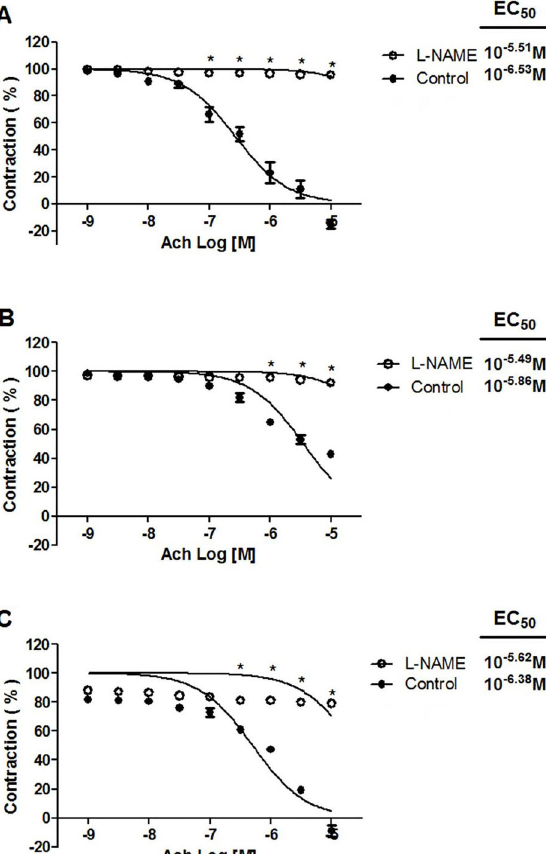
Figure 3. Effect of 10 – 7 M 1H-(1,2,4) oxadiazolo [4,3-a] quinoxalin- 1-one (ODQ) on acetylcholine (Ach) relaxation of endothelium- intact rat aortic rings precontracted with 10 – 6 M phenylephrine. The rings were extracted from rats fed: A ) the standard diet; B ) the cafeteria-style (CAF) diet; and C ) the CAF-diet plus rosuvastatin treatment. Data are reported as means ± SE of n = 6 observations. *P o 0.001 vs control (two-way